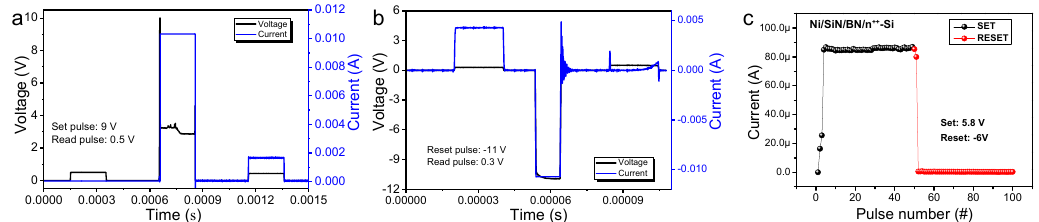
Figure 2. Transient characteristics of ( a ) set pulse of 9 V and ( b ) reset pulse of − 11 V. ( c ) Current as a function of 50 consecutive pulse responses (set: 5.8 V and reset: − 6 V).